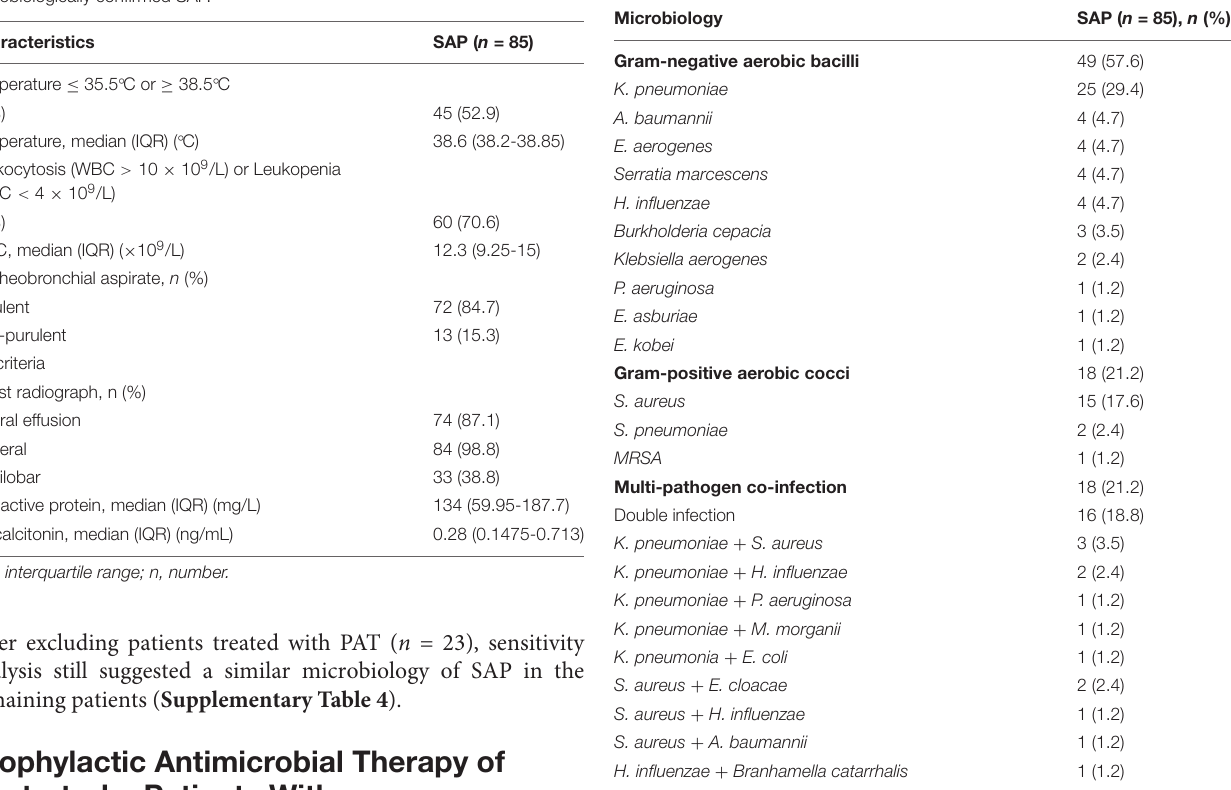
TABLE 3 | Microbial etiology of SAP in LRT.